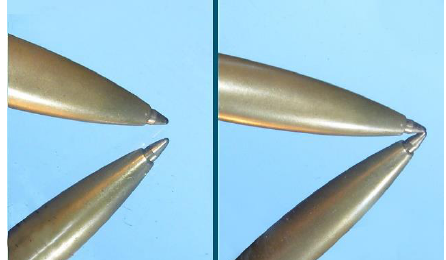
Figure 1: Effects of a back surface (left) and front surface (right) mirror) (Wikipedia, 2019)